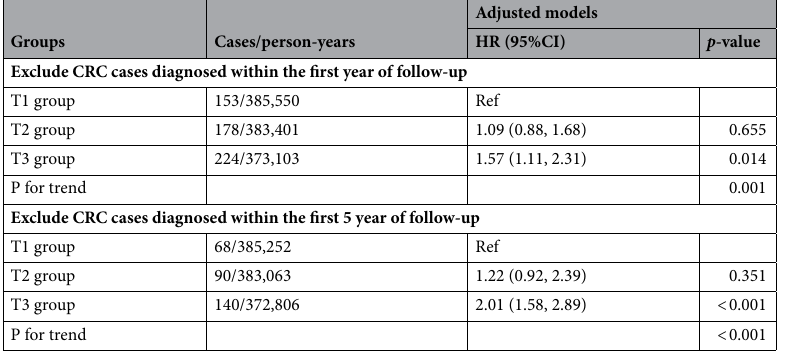
Table 4. Sensitivity analysis after excluding participants who occurred cancer within the first year and the first five years of follow-up. Models were adjusted for age (every 10 years), sex, family income, educational background, marital status, BMI, TG, TC, TBIL, ALT, CRP, smoking status, drinking status, physical activity, sedentary lifestyle, tea consumption, high-fat diet, diabetes, hypertension, chronic kidney disease, and family history of